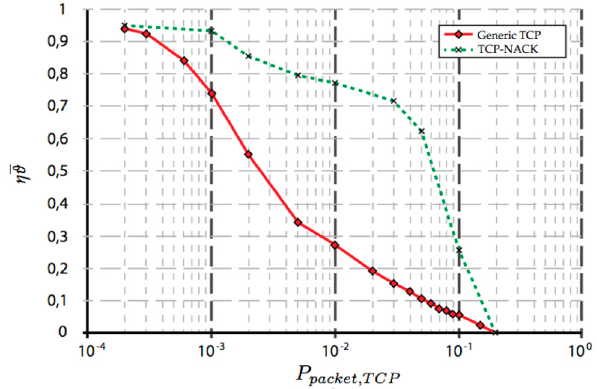
Figure 9. Emulated ηϑ as a function of the error packet probability. Table 6. Emulated link results.